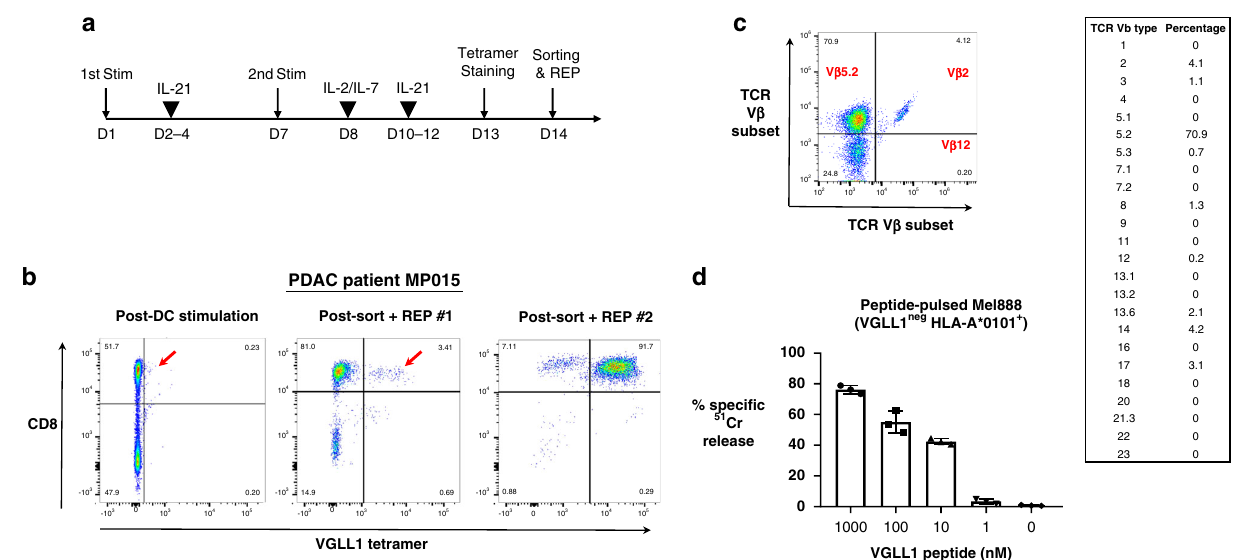
Fig. 4 Generation of VGLL1 antigen-speci fi c CTLs from peripheral blood of patient MP015. a Schematic outlining the experimental procedure for generating VGLL1-speci fi c CD8 + T cells from human donor PBMCs. b PBMCs isolated from PDAC patient MP015 by leukapheresis were stimulated with autologous LSELETPGKY peptide-pulsed dendritic cells (DCs). After two stimulations, CD8 + and VGLL1 tetramer-positive cells were sorted and expanded using a standard rapid expansion protocol (REP). VGLL1-speci fi c T cells were re-sorted and expanded a second time due to low numbers of antigen-speci fi